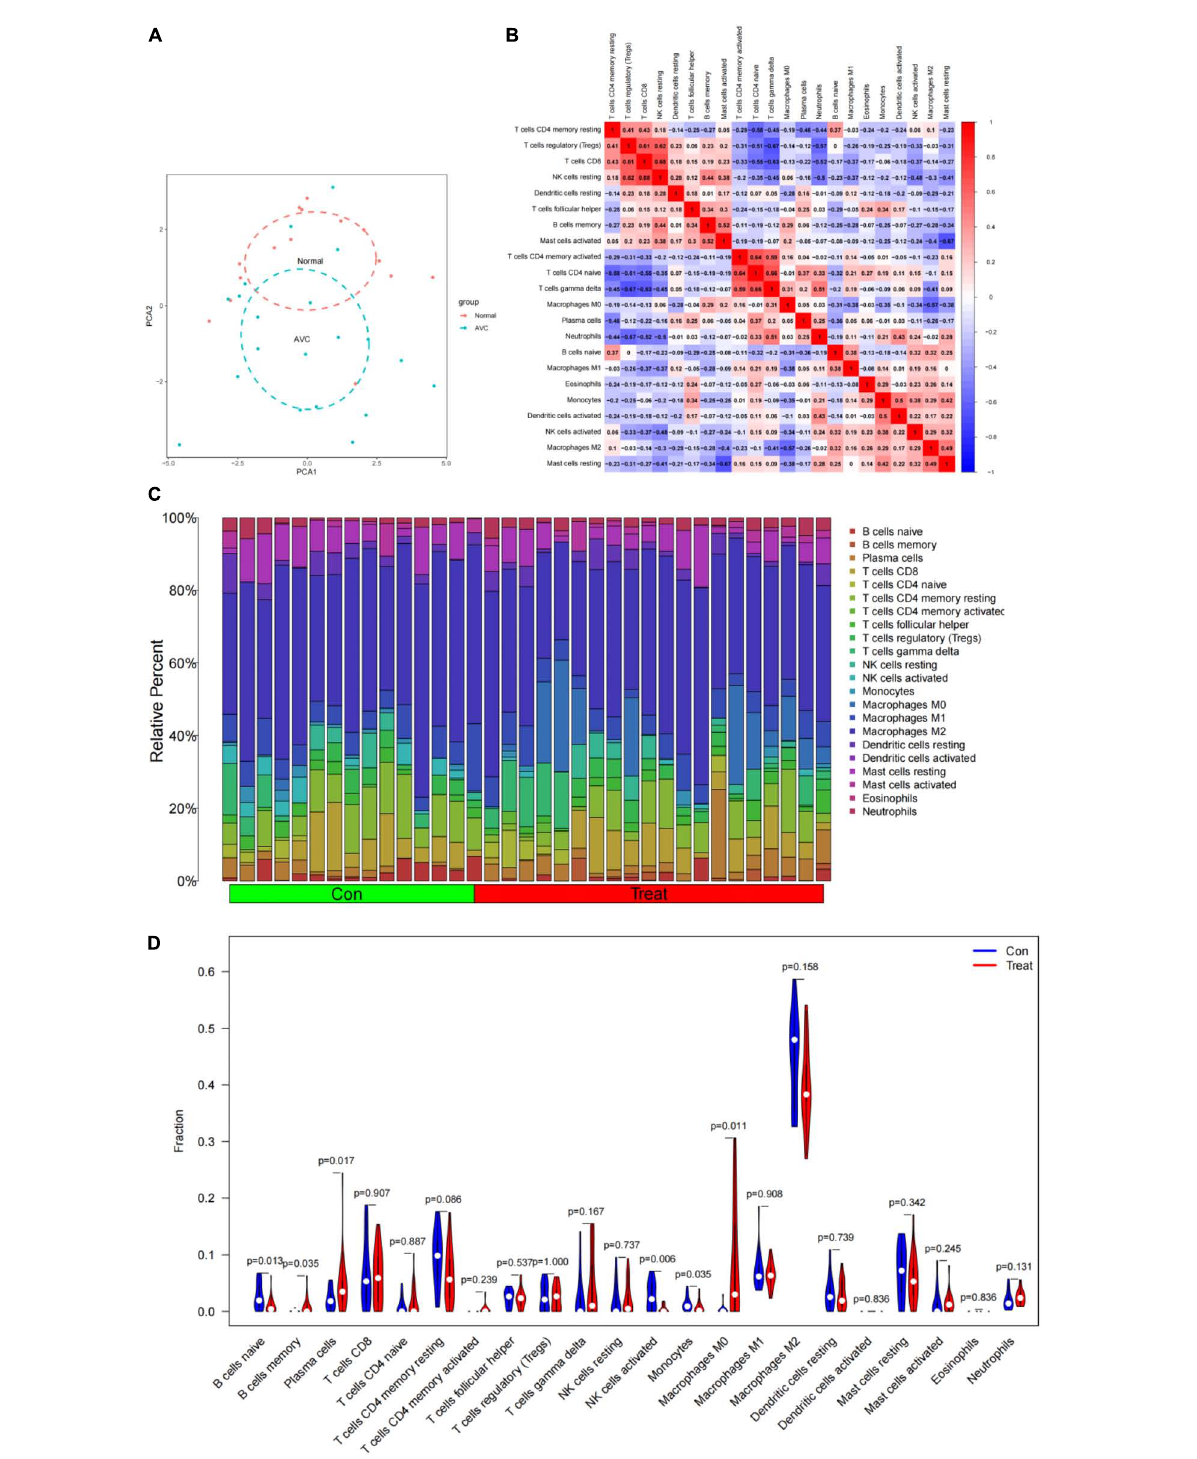
FIGURE10 Immune cell infiltrates are evaluated and illustrated. (A) Cluster plot of immune cell infiltration between AVC and normal samples using PCA. (B) Heatmap demonstrating correlations between 22 distinct types of immune cells. The size of the colored squares indicates the connection’s strength; red indicates a positive correlation, while blue indicates a negative correlation. A darker hue indicates a stronger connection. (C) Relative percentages of 22 immune cell subpopulations in 35 samples from the GSE12644 and GSE51472 datasets. (D) A violin diagram illustrating the relative proportions of 22 different kinds of immune cells. The red marks depict the infiltration difference between the two sets of